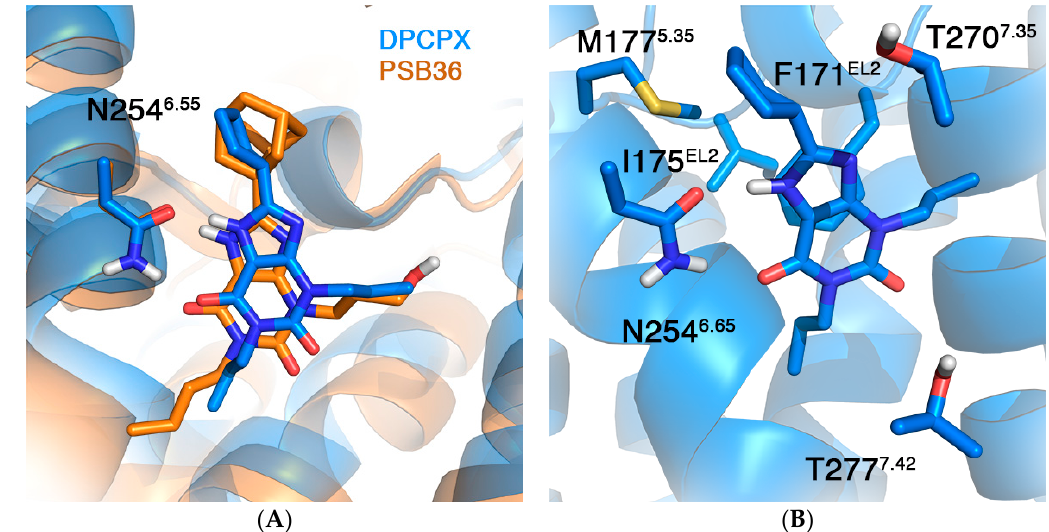
Figure 3. ( A ) Average structure from MD simulations of the DPCPX-A 1 AR complex (blue) superimposed with the crystal structure of the same receptor in complex with PSB-036 (PDB 5N2S); and ( B ) close